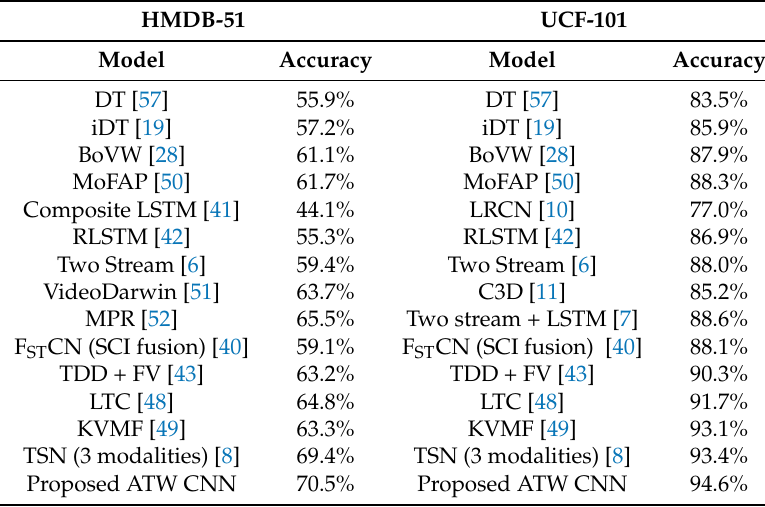
Table 5. Classification accuracies of the proposed ATW CNN and other state-of-the-arts on the UCF-101 dataset and the HMDB-51